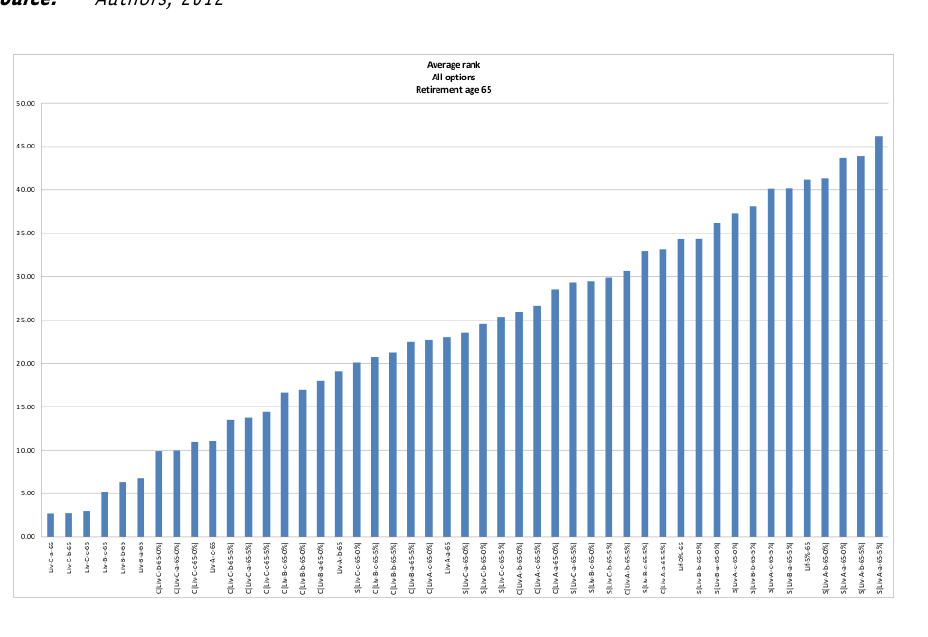
FIGURE 3: Average rank for all annuity strategies for a male retiree aged 65 Source: Authors,